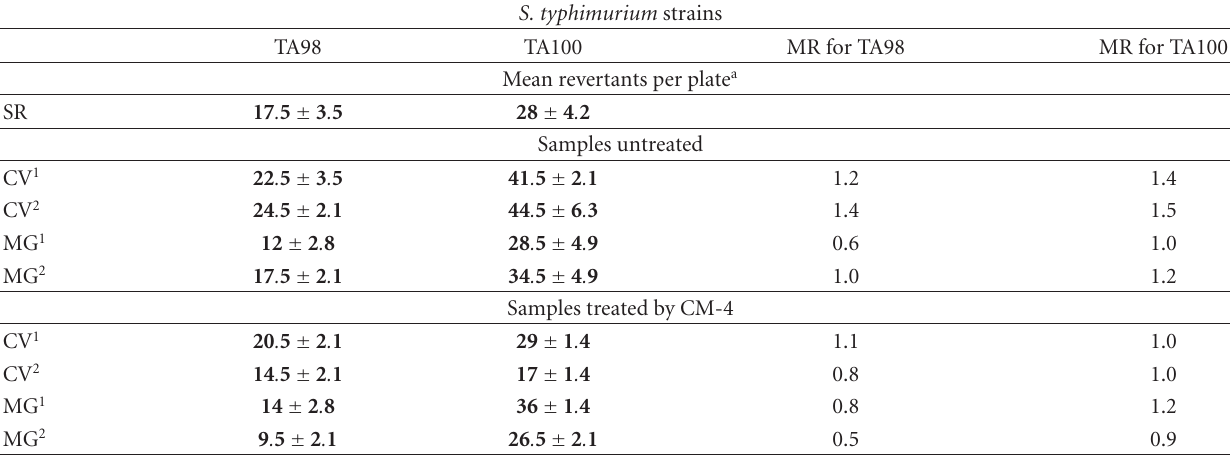
Table 3: Response of triphenylmethane dyes before and after treatment by a new bacterial consortium CM-4 in Salmonella typhimurium (TA98 and TA100) without metabolic